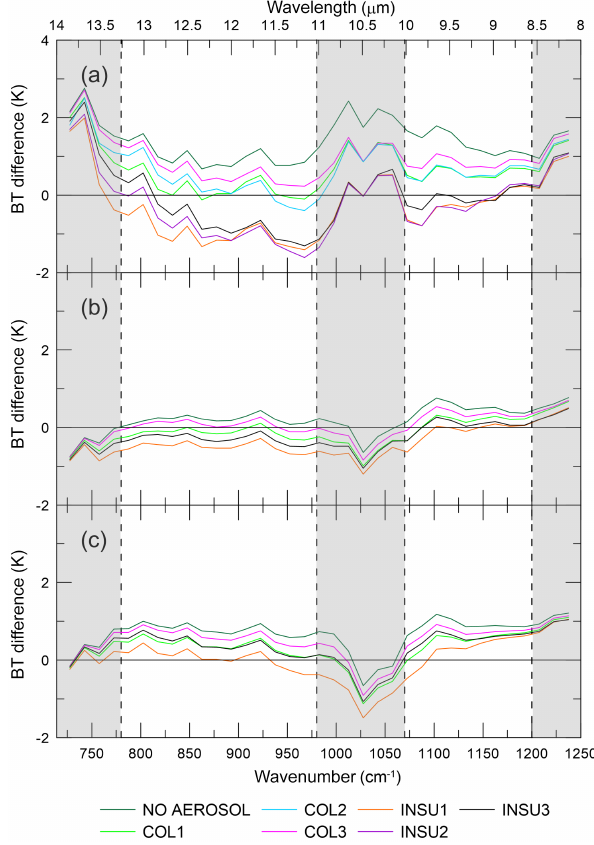
Figure 12. Differences between modelled and measured IASI BT spectra at the TOA for (a) 22 June, (b) 28 June, and (c) 3 July. Simulations have been performed with different AOPs and sampled at 15cm − 1 intervals. The vertical black dashed lines delimit the two spectral intervals (780–980 and 1070–1200cm − 1 ) where the differences are discussed, while the shaded areas are not considered in the